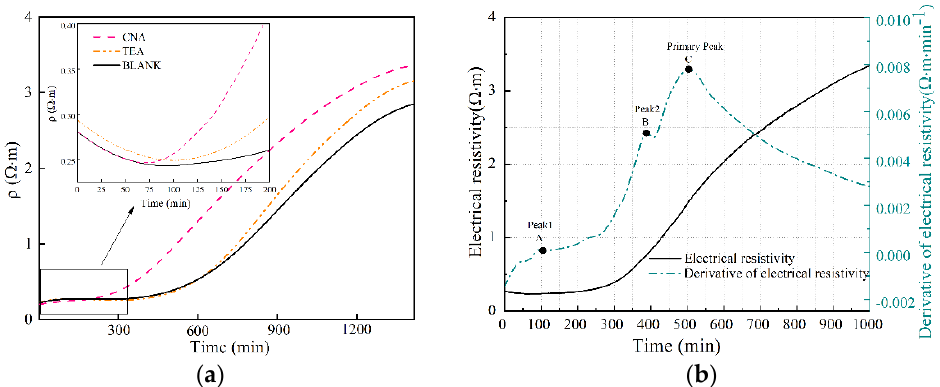
Figure 6. Resistivity development curve of cement slurry with different types of early strength agent ( a ) and the differential resistivity curve of the blank sample ( b ).